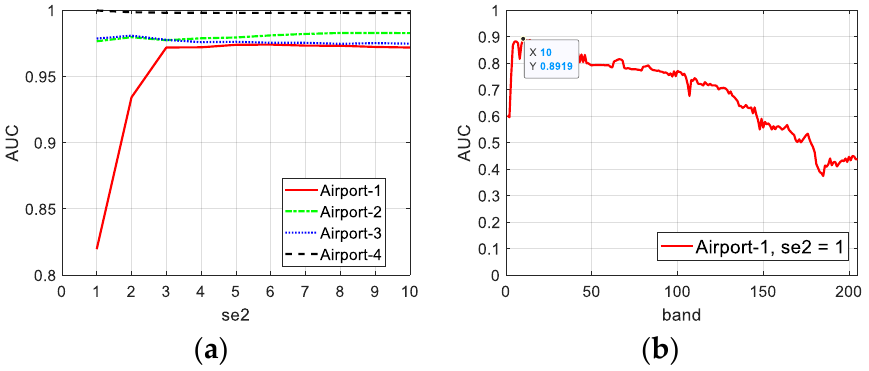
Figure 15. ( a ) Influence of the parameter se 2 over the MPAF performance on the ABU-Airport datasets. ( b ) The MPAF performance on the ABU-Airport-1 dataset at se 2 = 1. The bottom right of Figure 13 shows the influence of se 3 over the detection performance. As expected, the AUCs increased when se 3 was increased to a certain value, i.e., se 3 = 3. The dilation of the attribute filter expanded the objects in the image. Thus, the objects covered the lost pixels, which were caused by the AF process. The performance went down as se 3 was increased further, causing of